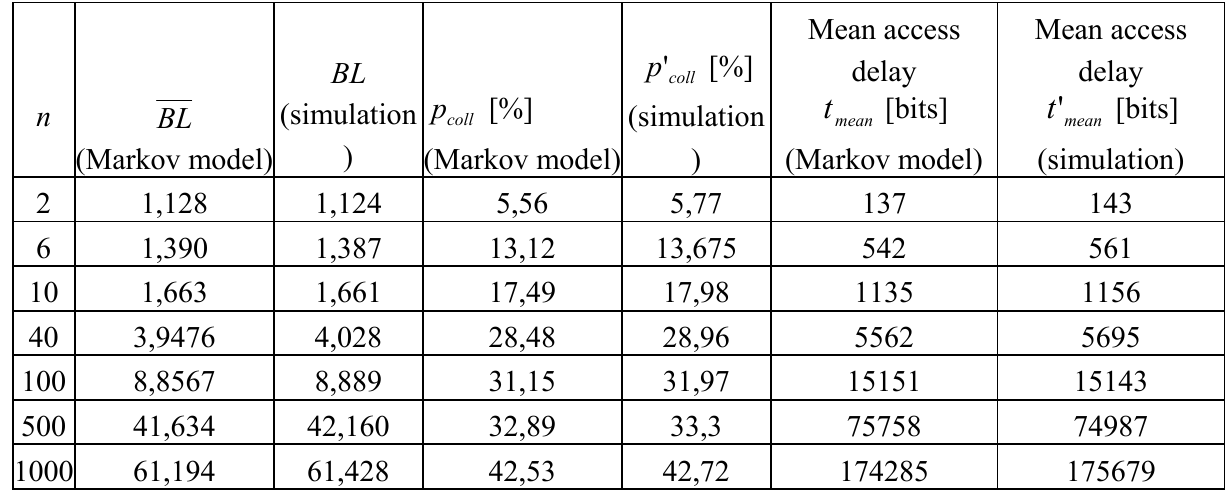
Table 1. The comparison of analytical and simulation results for ACK/unicast/CD load